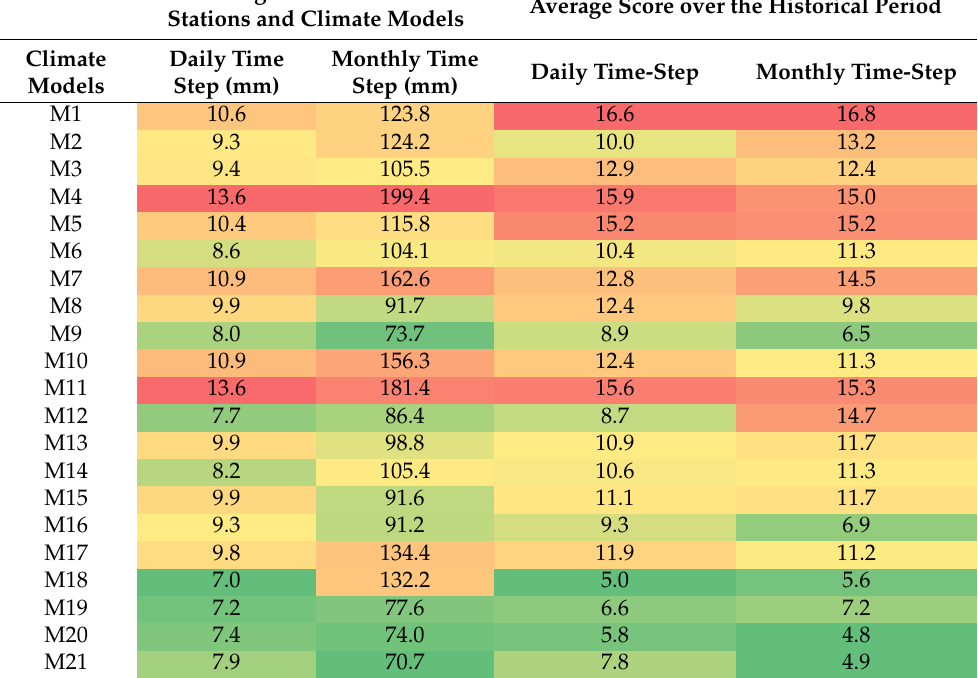
Table 4. Average overall score and RMSE value of all climate models from all rainfall stations in daily and monthly time steps over the historical period (1986–2005). Average RMSE from all Average Score over the Historical Period Stations and Climate Models Climate Daily Time Monthly Time Daily Time-Step Monthly Models Step (mm) Step (mm)